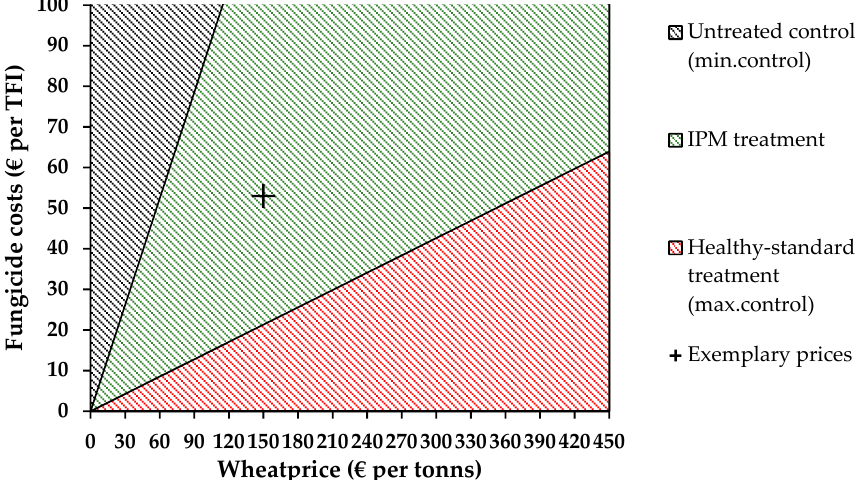
Figure 5. Equal Profit margin of untreated control versus IPM treatment and IPM treatment versus healthy-standard treatment from 1995 to 2021 as a function of wheat price ( € /t) and fungicide costs ( € /TFI). Exemplary wheat prices and fungicide costs of the survey area and period are shown as black cross.